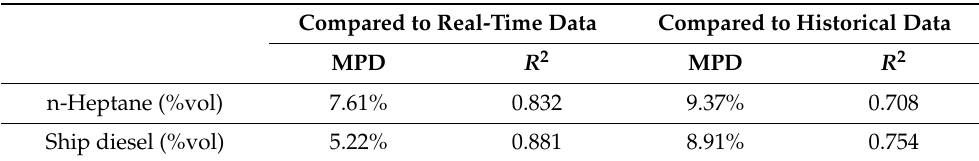
Table 4. Comparison of DT-driven predictions and actual data of shipping cargo